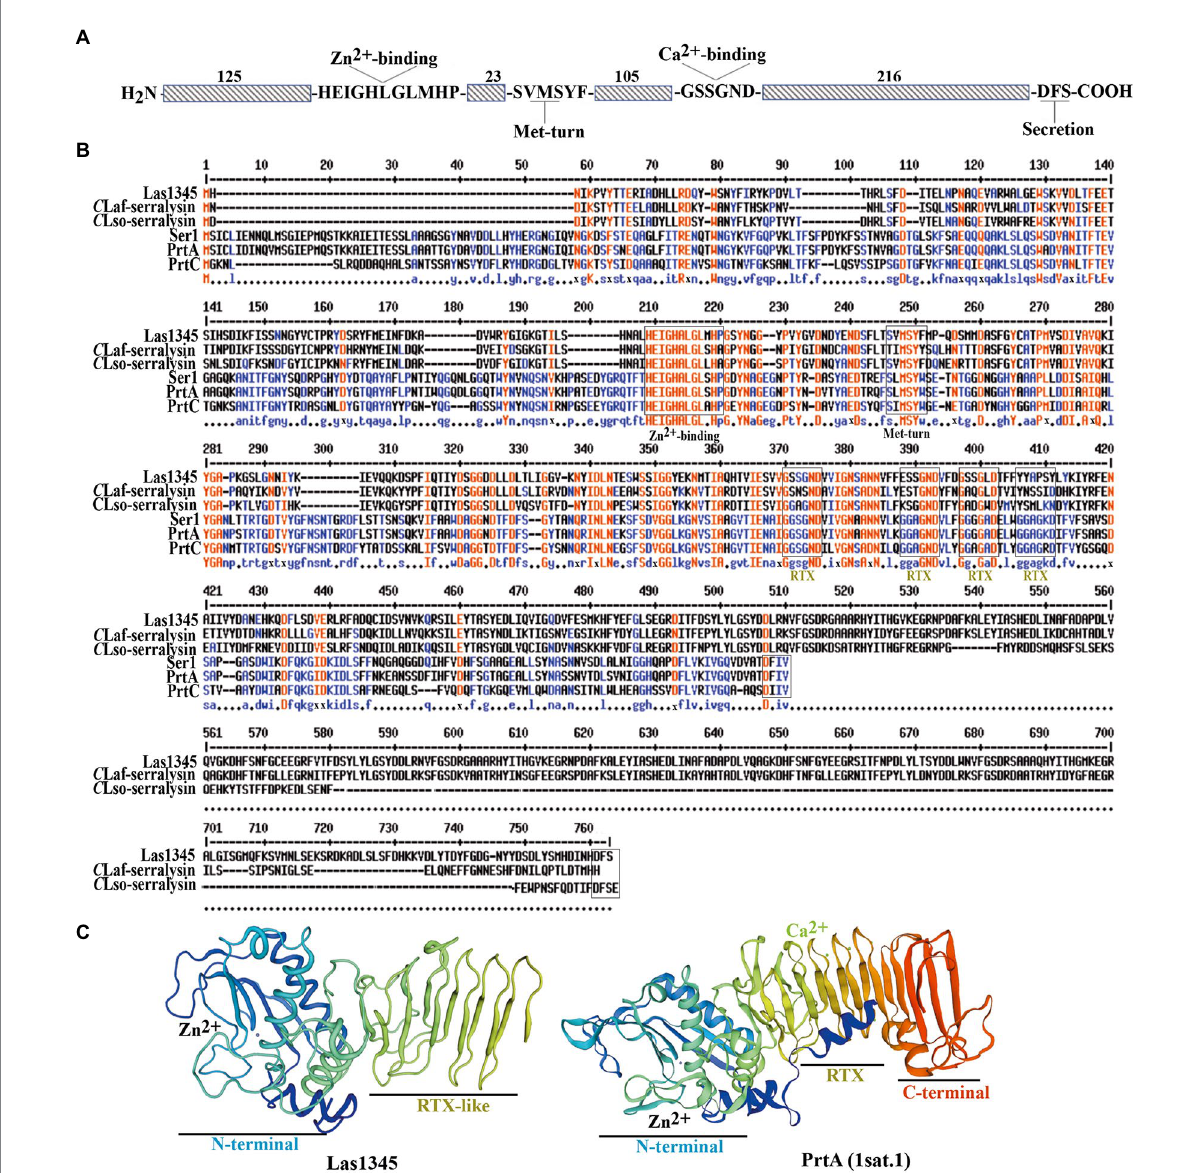
FIGURE 1 Multiple sequence alignment and representative tertiary structure of Las1345. (A) Schematic representation of Las1345 (CLIBASIA_01345). Conserved motifs associated with serralysin family protein are shown. HExxHxUGUxH, zinc-binding motif; SxMxY, a Met-turn motif; GGxGxDxUx, calcium-binding motif (glycine-rich repeats) where U represents an aliphatic amino acid and X can be any residue; Dxxx, T1SS secretion signal. (B) Sequence alignment of the serralysin-like proteins encoded by Candidatus Liberibacter ( Ca L) asiaticus ( C Las) strain psy62 (Las1345, WP_015452346); Ca L africanum strain PTSAPSY ( C Laf_Serralysin, AKK19938.1); Ca L solanacearum strain ZC1 ( C LsoB_Serralysin, WP_013461860); Serratia marcescens (PrtA, CAA39139.1); S. liquefaciens strain FK01 (Ser1, BAK39731) and Dickeya chrisantemy strain B374 (PrtC; PDB 1K7I_A). Alignment was obtained by ClustalW and Multaline. Low consensus alignment (50%) is shown in blue letters while high consensus alignment (90%) is shown in red. Protein domains were identified by Pfam. Protein domains, showing the metalloprotease sequence (HExxHxxGxxHP) motif, the met-turn (SxMSYF/W) motif, the four RTX repeats (the classic, GGxGxD and the divergent, GSxGxD) and the ABC exporter motif (Dxxx) are indicated in boxes. (C) Tertiary structure of Las1345 domains based on a homology model derived from PrtA structure (PBD ID 1sat.1; Baumann, 1994; QMEANG 0.65 ± 0.5). The N terminal Zn-binding domain and the RTX β -rolls are colored in rainbow. Zinc and calcium ions are represented by gray and green spheres,